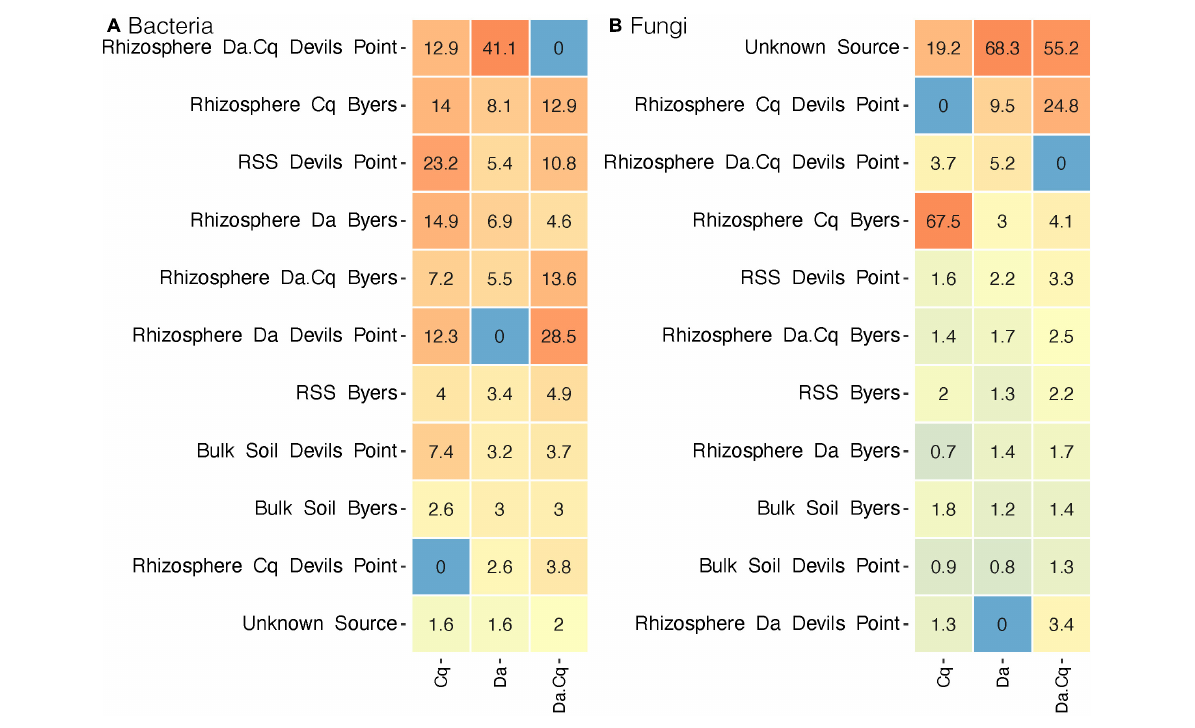
FIGURE6 SourceTracker analyses for bacteria (A) and fungi (B) in the rhizosphere of Deschampsia antarctica [Da], Colobanthus quitensis [Cq], and their association [DaCq]. Rhizosphere samples collected at Devil’s Point were considered sinks and samples from other sites in Byers as potential sources for bacteria and fungi. Heatmap colors represent the relative contribution of each source to the plant’s rhizospheres composition on a logarithmic scale.